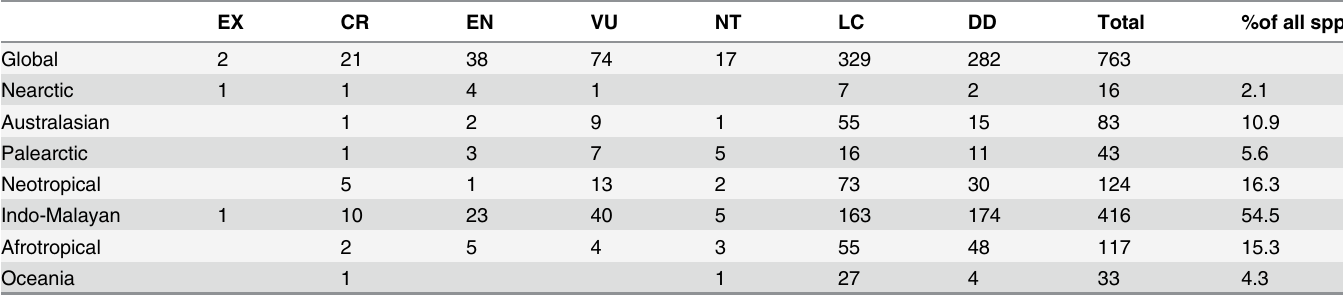
Table 1. Number of freshwater shrimp species in each threat category, globally and according to biogeographic realm. EX